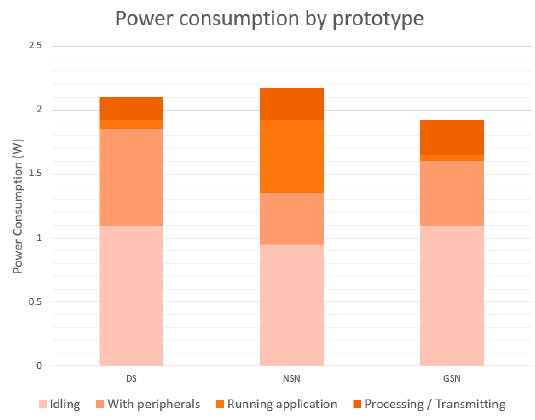
Figure 15. Power consumption by prototype.